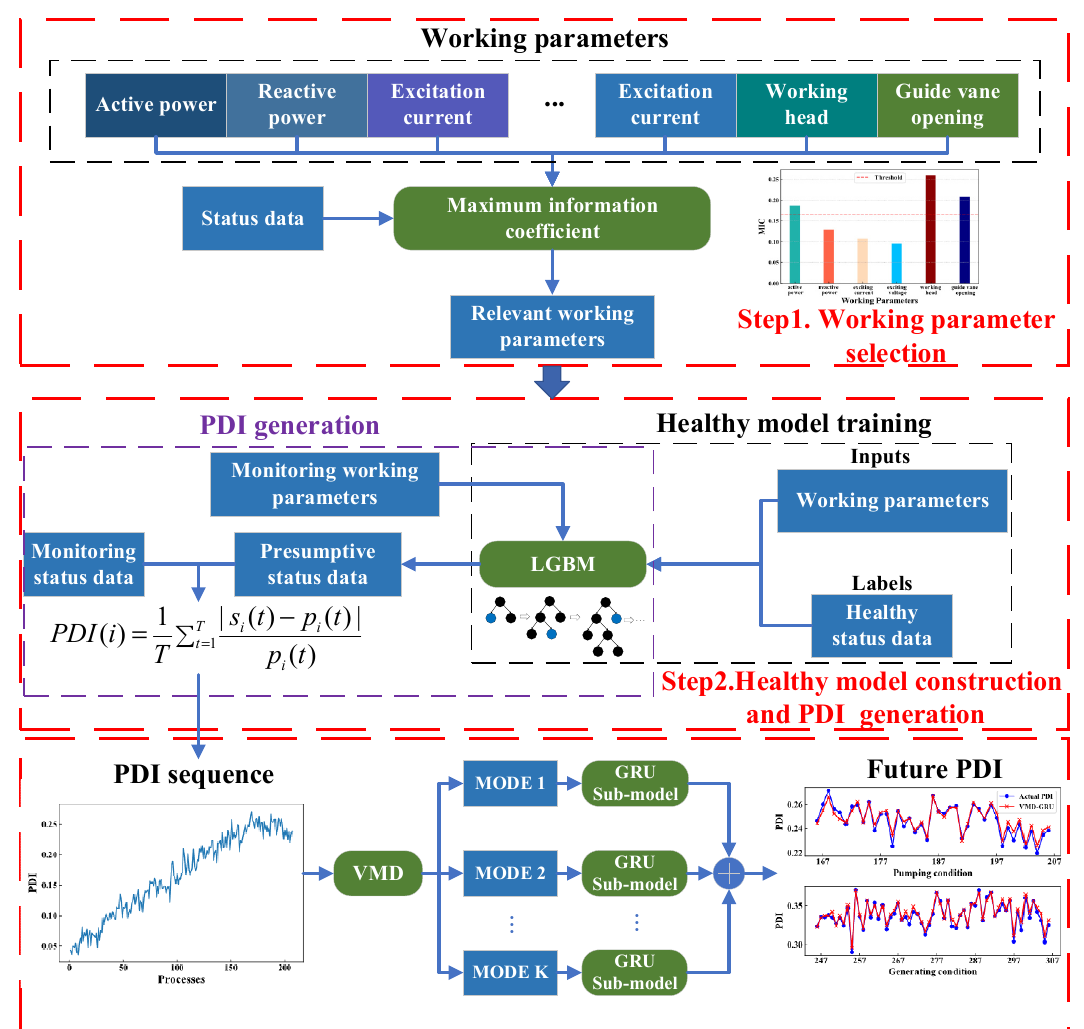
Figure 4. Proposed DTP model.